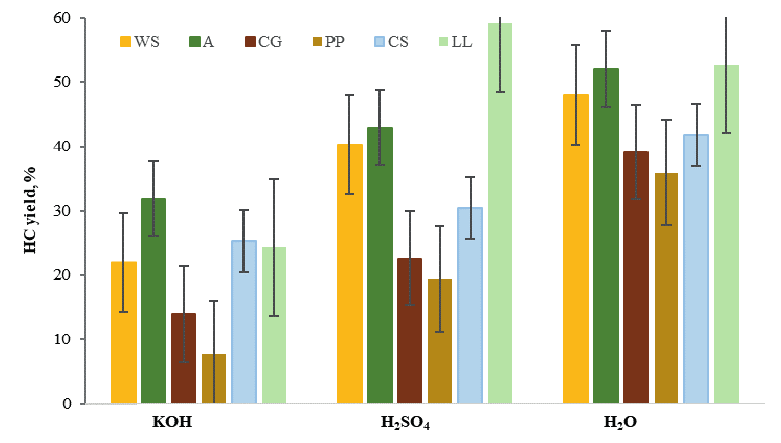
Fig. 6. Yield of hydrochar (HC) depending on the hydrothermal carbonisation environment (KOH, H 2 O or H 2 SO 4 ) (24 h, 200